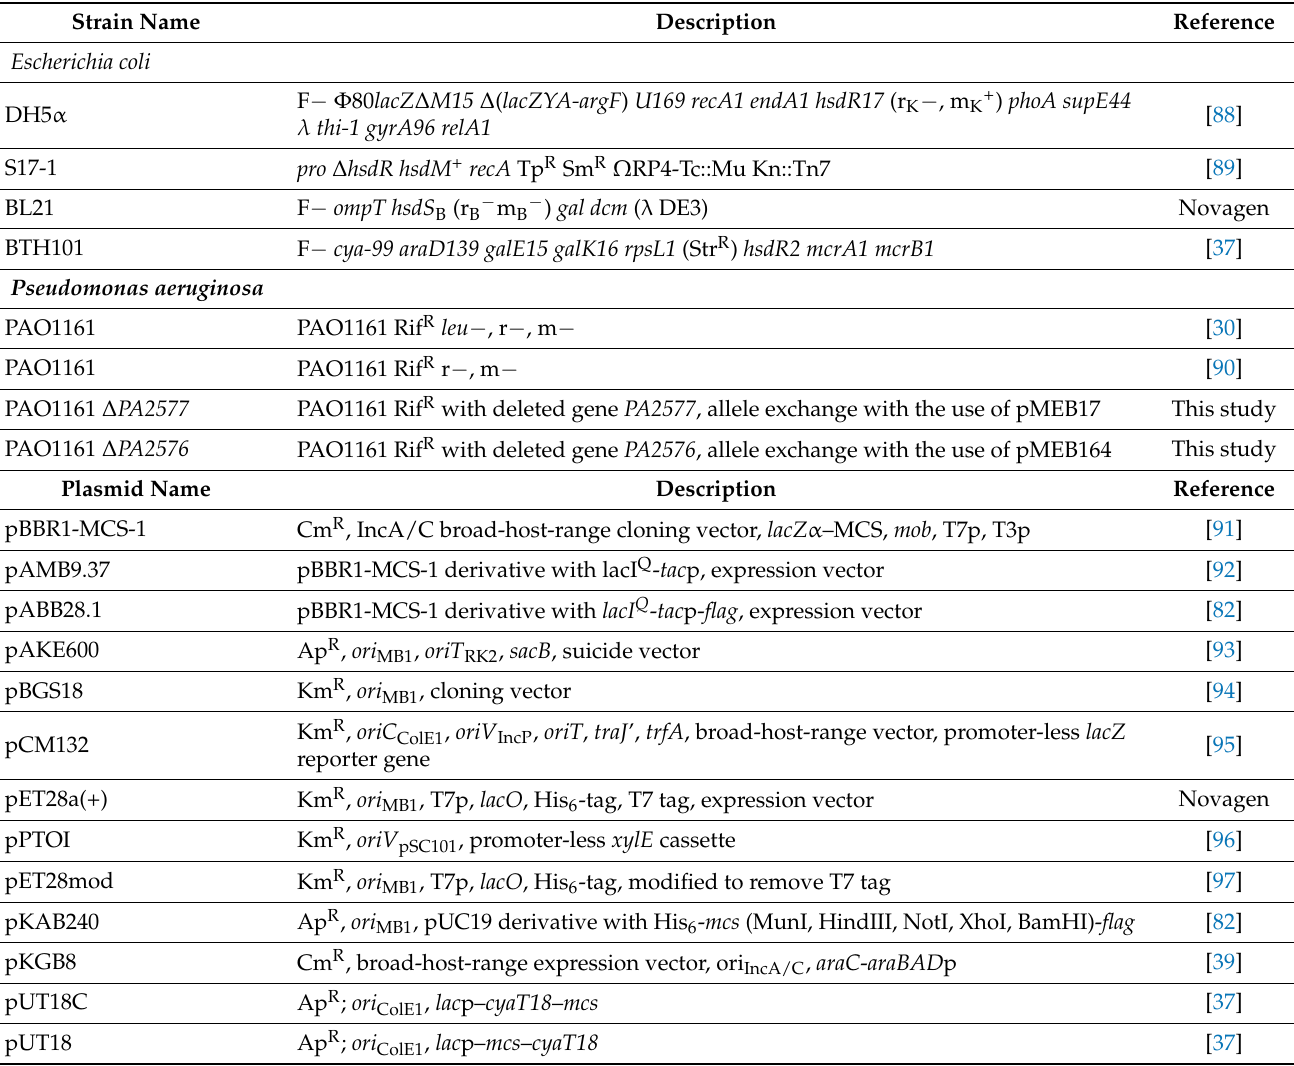
Table A1. Bacterial strains and plasmids used and constructed in this